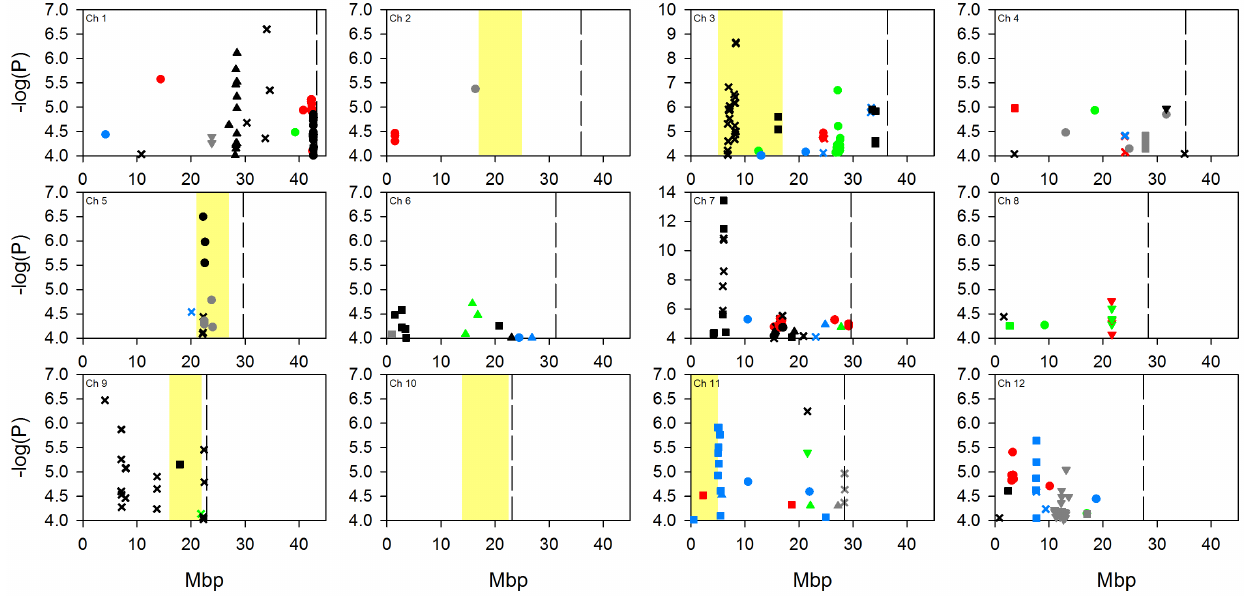
Figure 1. GWA mapping of grain arsenic concentration at the five field sites across the 12 rice chromosomes. Data points represent SNPs significantly associated (p , 0.0001) with the trait and which have a MAF . 5%. Significant SNPs from different experiments are displayed with different coloured symbols: 2006 Arkansas are red, 2007 Arkansas are black, 2009 Texas are blue, Faridpur are green, and Qiyang are grey. Analyses of the combined subpopulation groups and separate subpopulations are represented by different symbols: combined analysis=X, aus =circle, indica =square, tropical japonica =triangle, temperate japonica =inverted triangle. Yellow highlighted bars indicate regions of mapped QTLs for grain arsenic concentration (21, 22). Dotted lines indicate chromosome